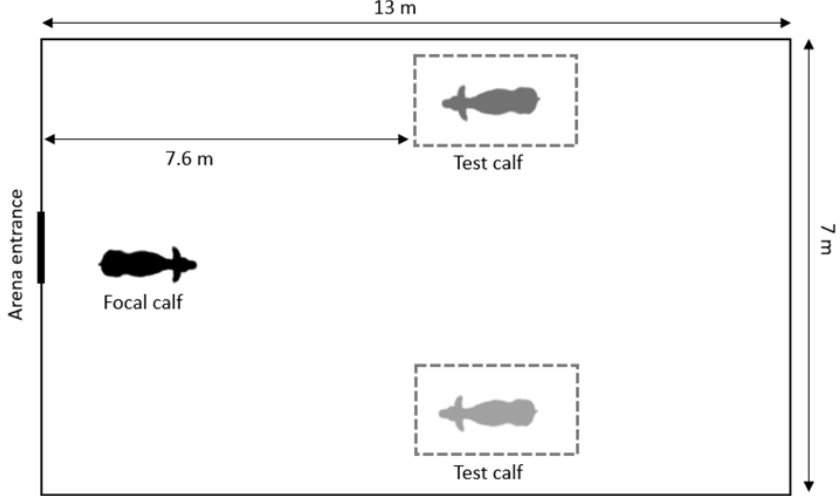
Figure 1. Layout of the social preference test within the testing arena, showing the placement of the stimulus calves (the ‘more familiar’ and ‘less familiar’ calves; side randomized) relative to the en2.4. Behavioral Observations and Calculations